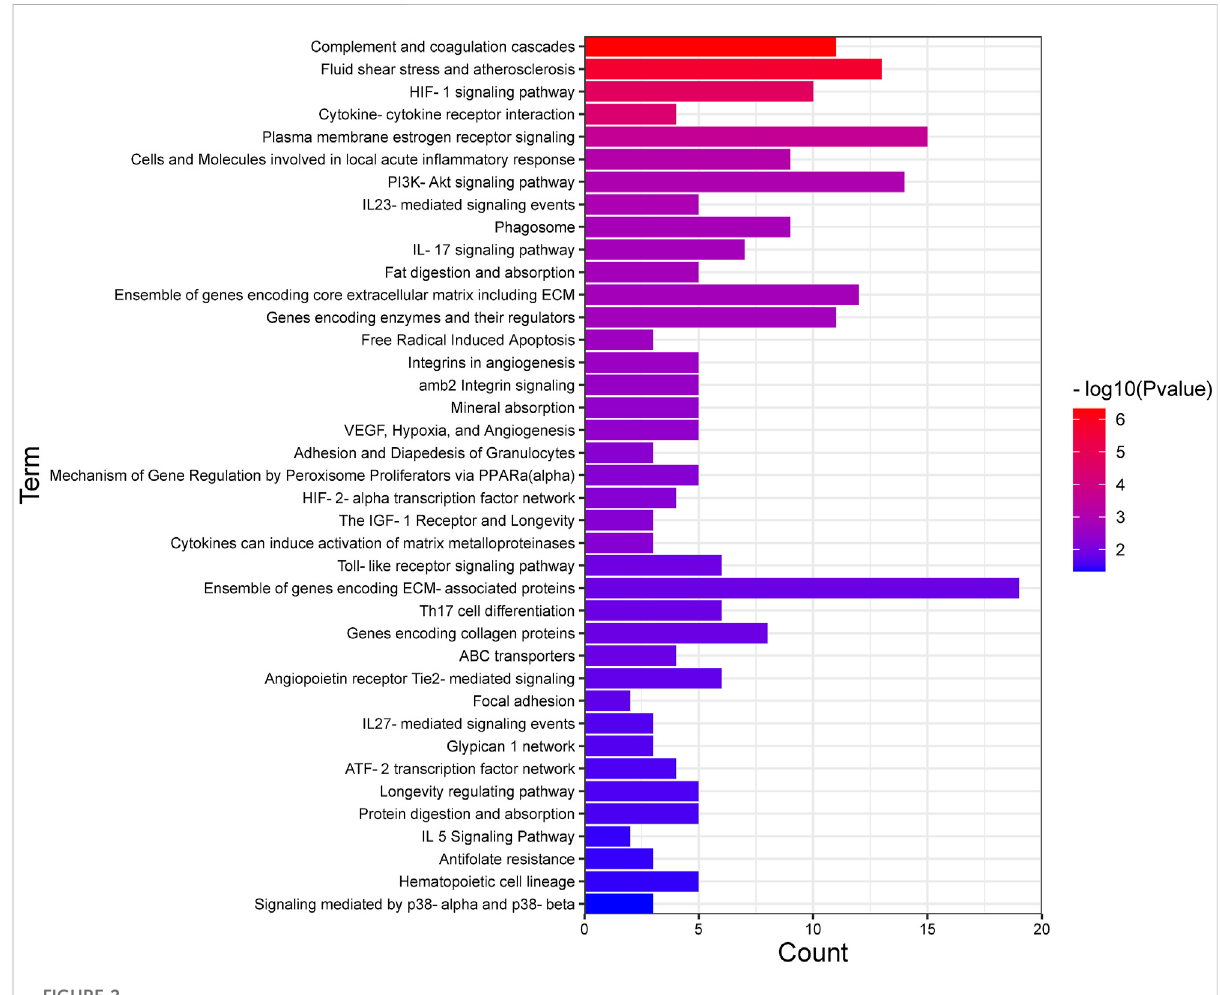
FIGURE 2 All the pathways enriched in AMDgset ranked by signi fi